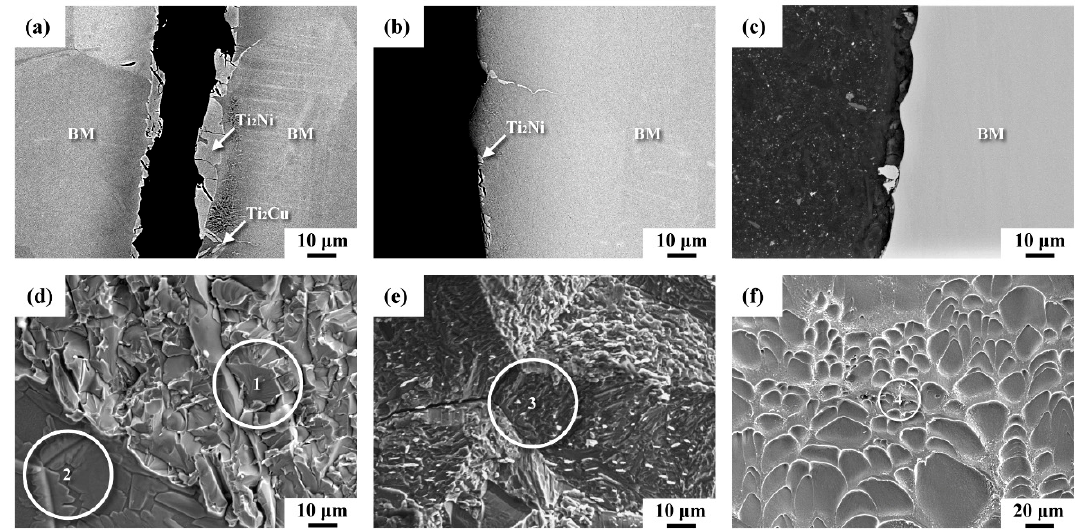
Figure 9. ( a – c ) BSE images showing the cross sections of the fractured B3, B10 and B30 joints; ( d – f ), SE image fractographs revealing the fracture features of the B3, B10 and B30 samples. Table 4. Electron probe micro-analyzer (EPMA) chemical compositions in at% of marked sites in Figure 9.